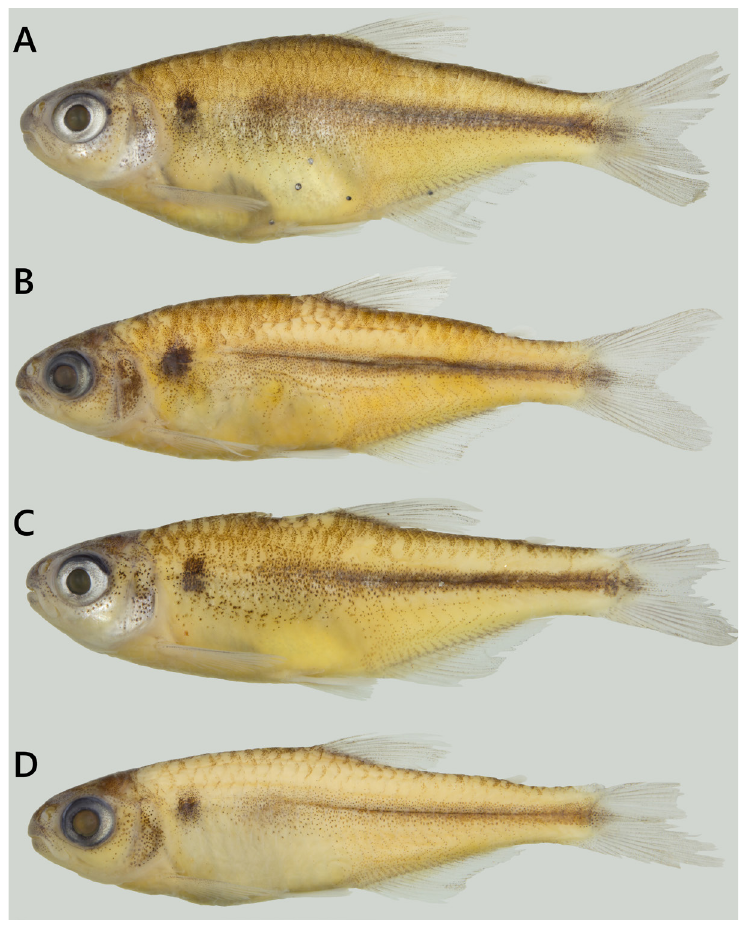
FIGURE 3 | Knodus rufford , paratypes. Ontogenetic and polymorphic variation of the body shape and colour patterns. All from the ribeirão Dois Irmãos drainage, upper Tocantins basin in Pirenópolis, Goiás State, Brazil. A . NUP 22669, 39.2 mm SL. B . CPUFMT 6835, 31.7 mm SL. C . NUP 22669, 28.1 mm SL. D . CPUFMT 6835, 25.2 mm